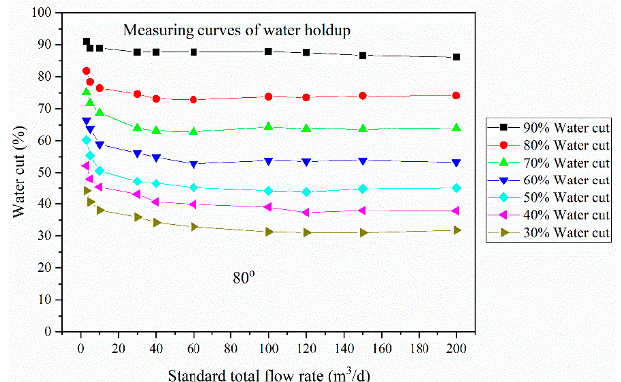
Figure 5. Water holdup measurement chart (inclination angle 80°).